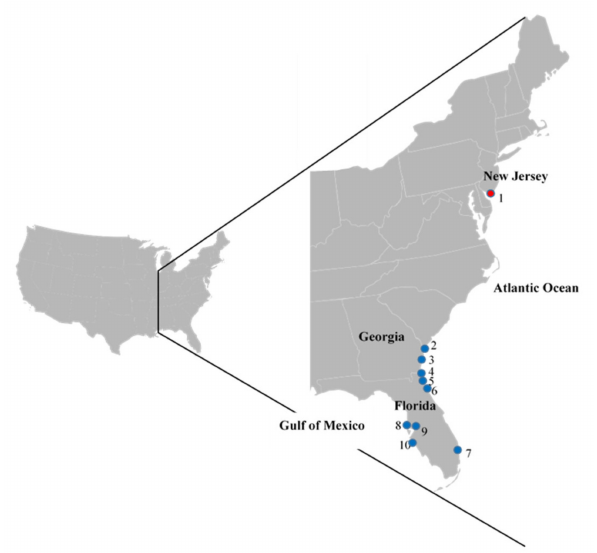
Figure 1. Relative location of collection sites in Florida and Georgia, USA, depicted by blue markers; the Delaware Bay spring migratory stopover site is designated with a red marker (1). States and water body names are included for orientation. Southeastern locations, by county (Co.) include: (2) Chatham Co., GA; (3) Glynn Co., GA; (4) Nassau Co., FL; (5) Duval Co., FL; (6) St. John’s Co., FL; (7) Palm Beach Co., FL; (8) Pinellas Co., FL; (9) Hillsborough Co., FL; and (10) Longboat Keys, FL. The map of the contiguous United States and the adapted inset were used under CC BY-SA 3.0 (https: // creativecommons.org / licenses / by-sa /